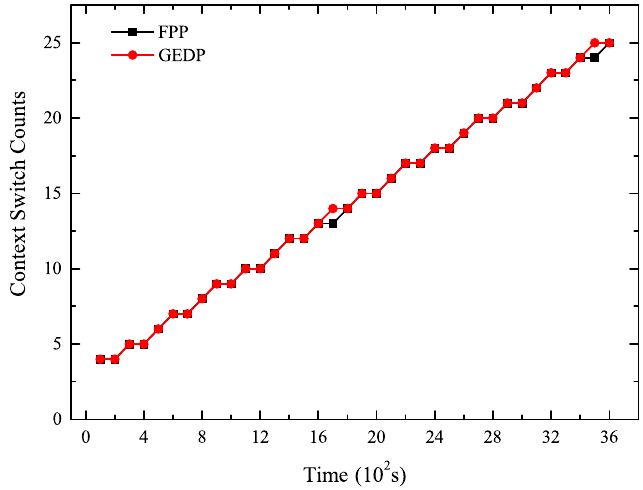
Figure 6. Voluntary context switches of